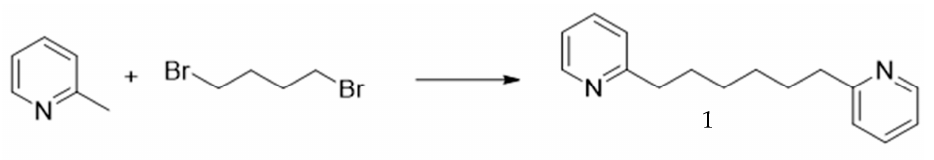
Figure 9. Chemical structure of the compounds under study with spacer six methylene long.